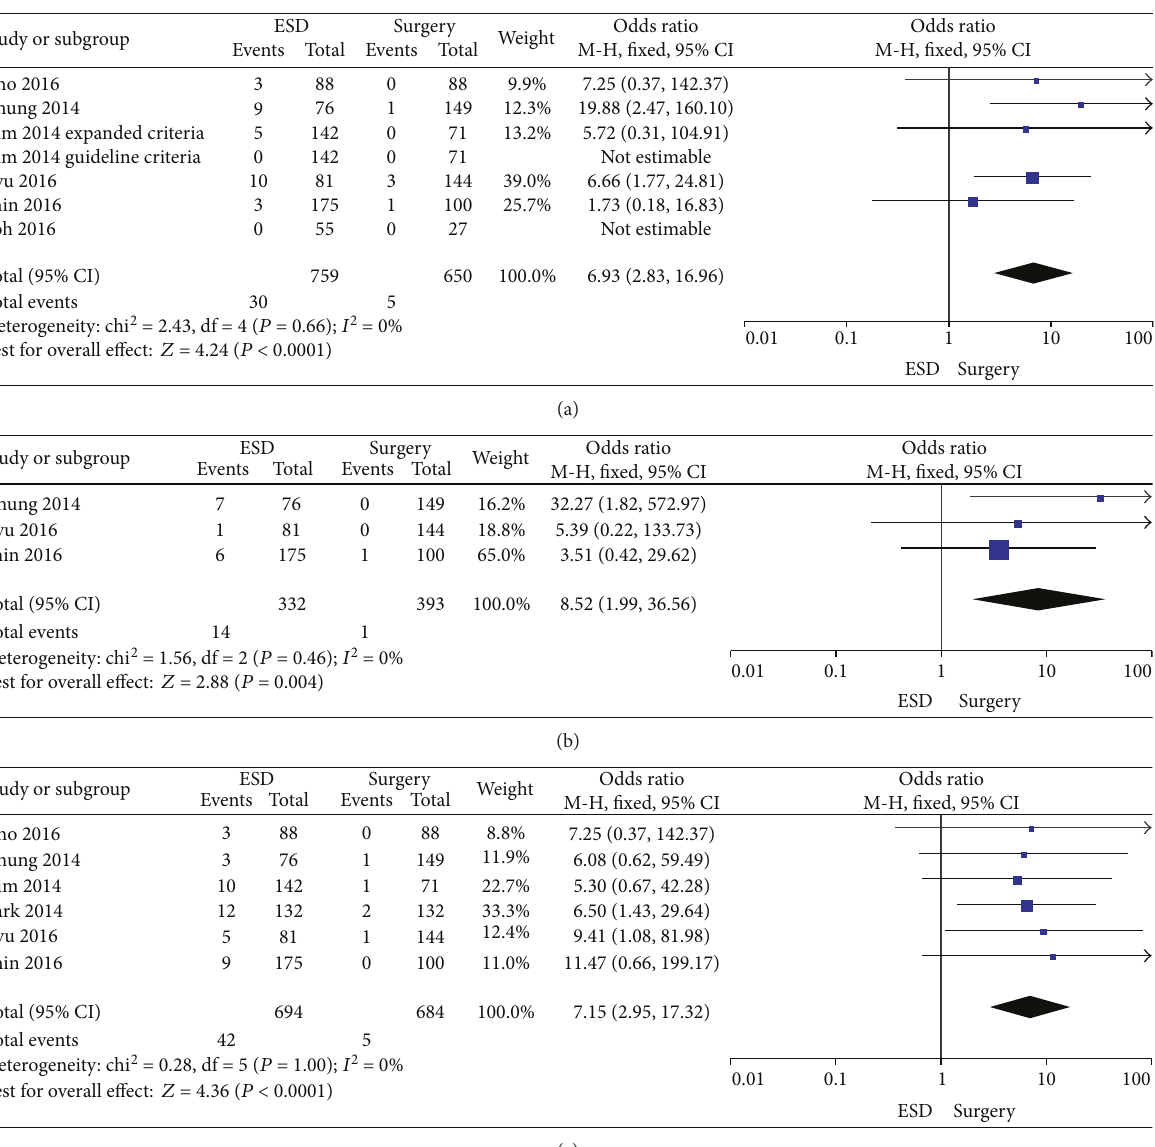
Figure 3: Forest plots showing the results of meta-analysis comparing the prevalence of recurrence, synchronous cancer, and metachronous cancer between patients with ESD and surgery. (a) Comparing the prevalence of recurrence between ESD and surgery. (b) Comparing the prevalence of synchronous cancer between ESD and surgery. (c) Comparing the prevalence of metachronous cancer between ESD and surgery. ESD: endoscopic submucosal